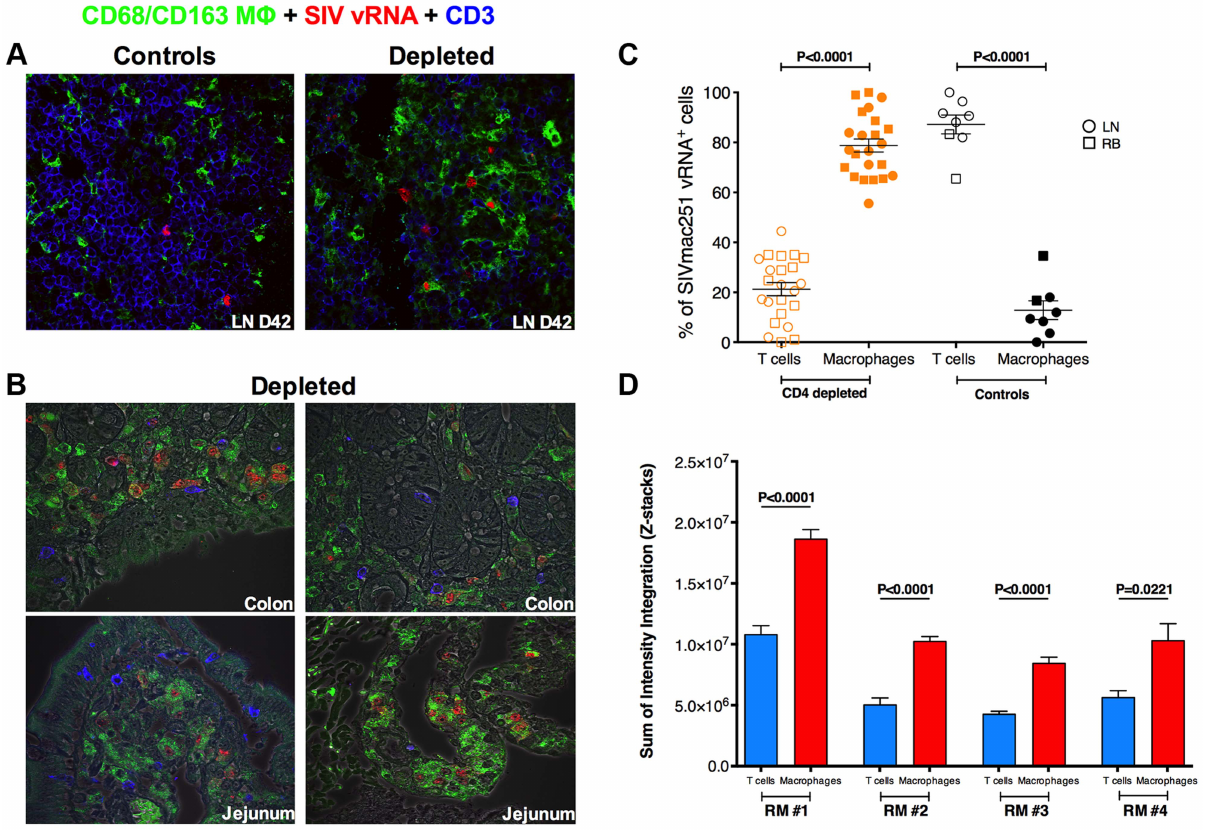
Figure 4. Massive SIV infection of LN and intestinal macrophages in CD4-depleted RMs. ( a ) Immunofluorescence staining for T cell (CD3; blue) and macrophage (CD68 and/or CD163; green) lineage markers combined with in situ hybridization for SIV vRNA (red) in the LN isolated at day 42 post-infection from one representative undepleted control (left) and one CD4-depleted RM. The vast majority of SIV vRNA + cells express CD3 in undepleted control but express CD68/CD163 in CD4-depleted RM. ( b ) The same staining is shown for colon (top) and jejunum (bottom) tissues in two representative CD4-depleted animals. ( c ) Quantitative image analysis of LN and mucosal tissues showing the fraction of SIV vRNA + cells that express CD3 or CD68/CD163 in CD4-depleted (n=12; the 8 animals in this study plus the 4 in Ortiz et al 2011 ) or undepleted control RMs (n=6; two SIVmac251 infected animals belonging to a different study were added as controls). ( d ) Relative abundance of SIV vRNA + in productively infected T cells and macrophages, determined by measuring the volumetric sum of the SIV vRNA + intensity integration values in situ from confocal images collected under identical laser settings, is shown in four CD4-depleted RMs. Macrophages on average have higher per cell SIV vRNA + content compared to CD4 + T cells within the same host. Statistical analyses were determined by Mann-Whitney